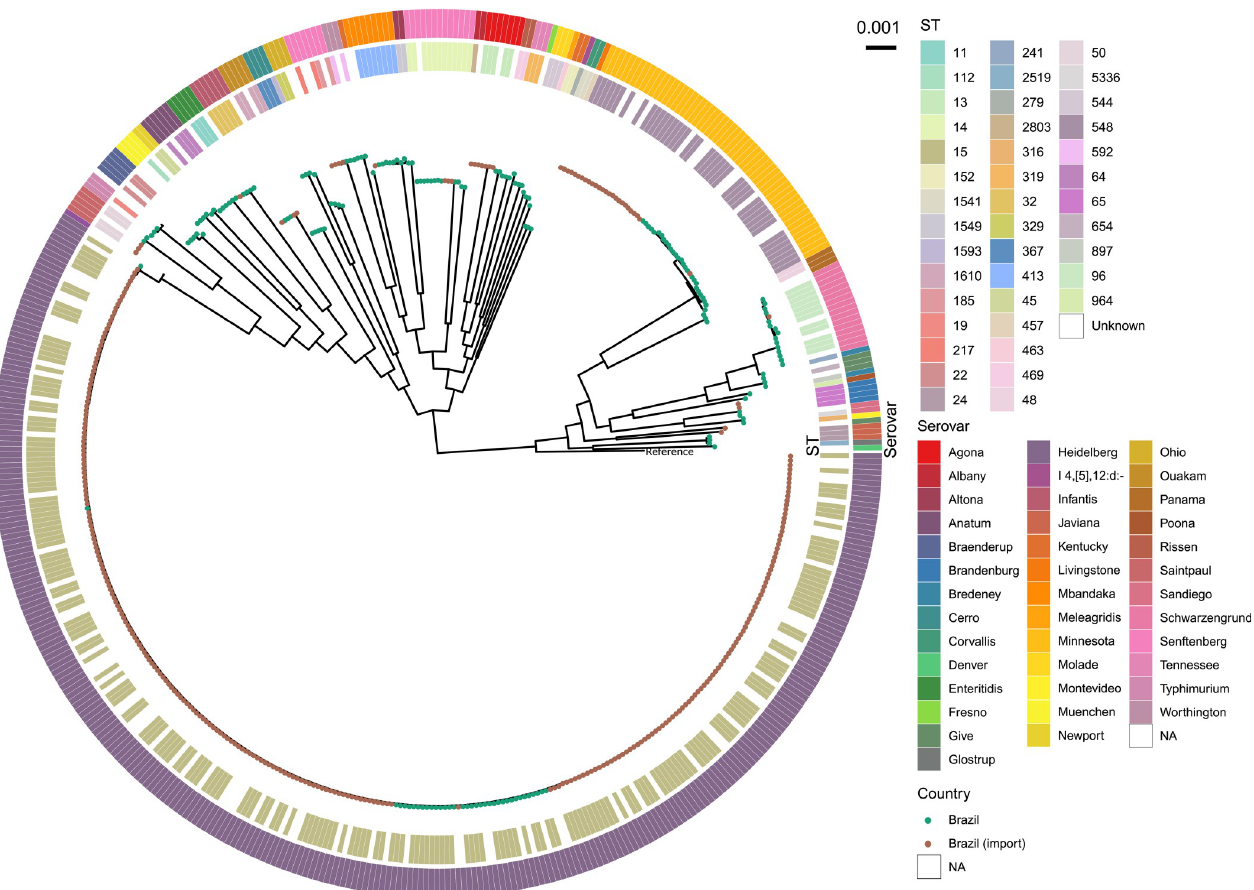
Fig 1. Genomic phylogeny of S . enterica isolates sampled in Brazil and imported chicken meat from Brazil. Maximum likelihood phylogeny of core genome alignment (253,248 informative sites) from 495 genomes of S . enterica isolated from Brazilian poultry production (tips—green) or known UK imports (tips—brown). Inner ring indicates sequence type (MLST) according to the key. Outer ring indicates serovar, predicted by SISTR. An interactive version of this figure with supporting metadata is available at https://microreact.org/project/brch-figure1.